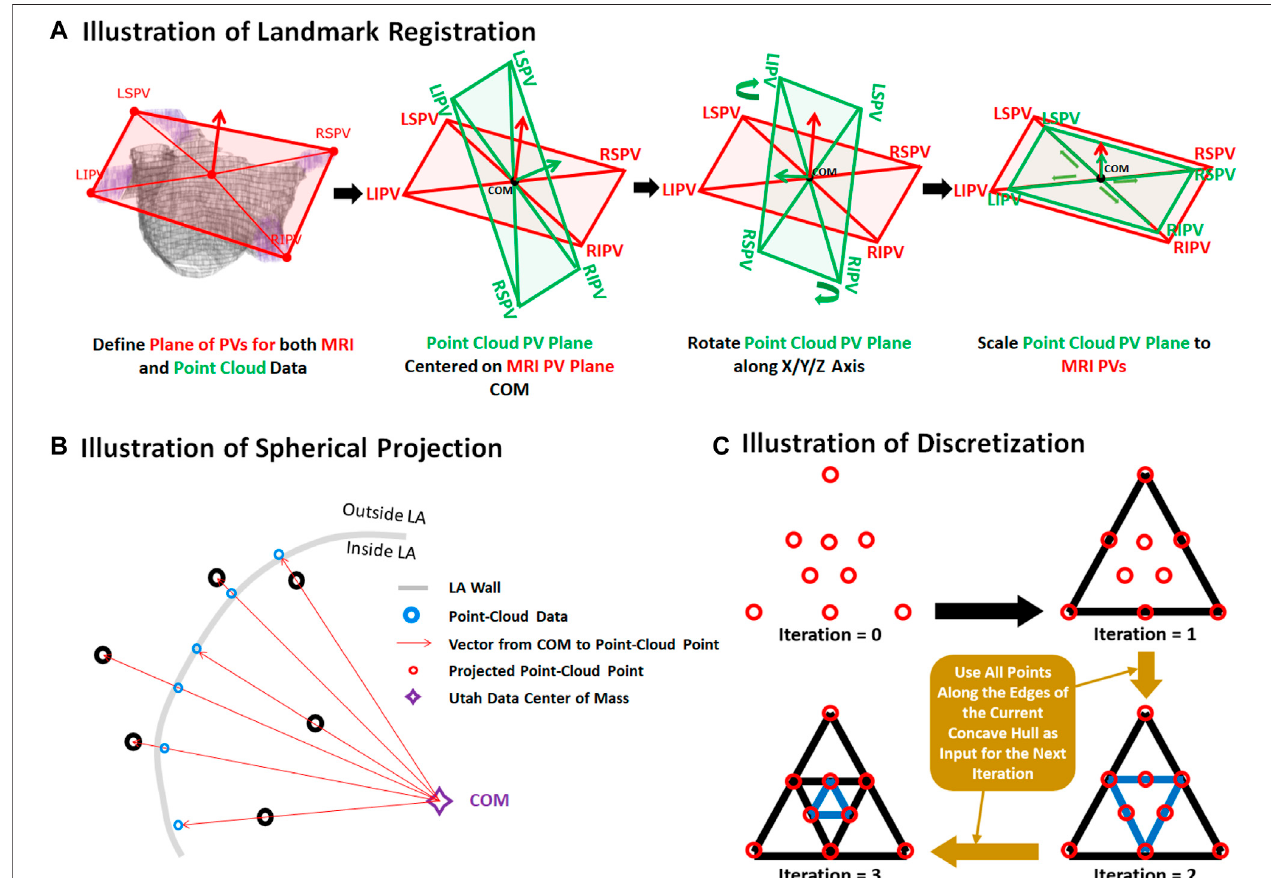
FIGURE 2 | Illustration of the (A) registration, (B) projection, and (C) discretization stages for data generation from pairs of 3D left atrial (LA) geometry segmented from magnetic resonanceimaging(MRI)andpoint cloudsoftheLArecorded duringclinicalmapping.Landmarkregistrationwas fi rst performedtoapproximately match the pulmonary veins (PV) of the two LA geometries. This was performed by centering the center of mass (COM) of the point cloud PVs to the MRI. The point cloud was then rotated such that the PVs was able to closely match that of the MRI. The point cloud was lastly scaled for further re fi nement. The registered point cloud was spherically projected radially from the COM to the LA wall of the MRI to simulate a surface-point cloud recording on the MRI. The point cloud was lastly converted into a dense mesh using the concave hull.